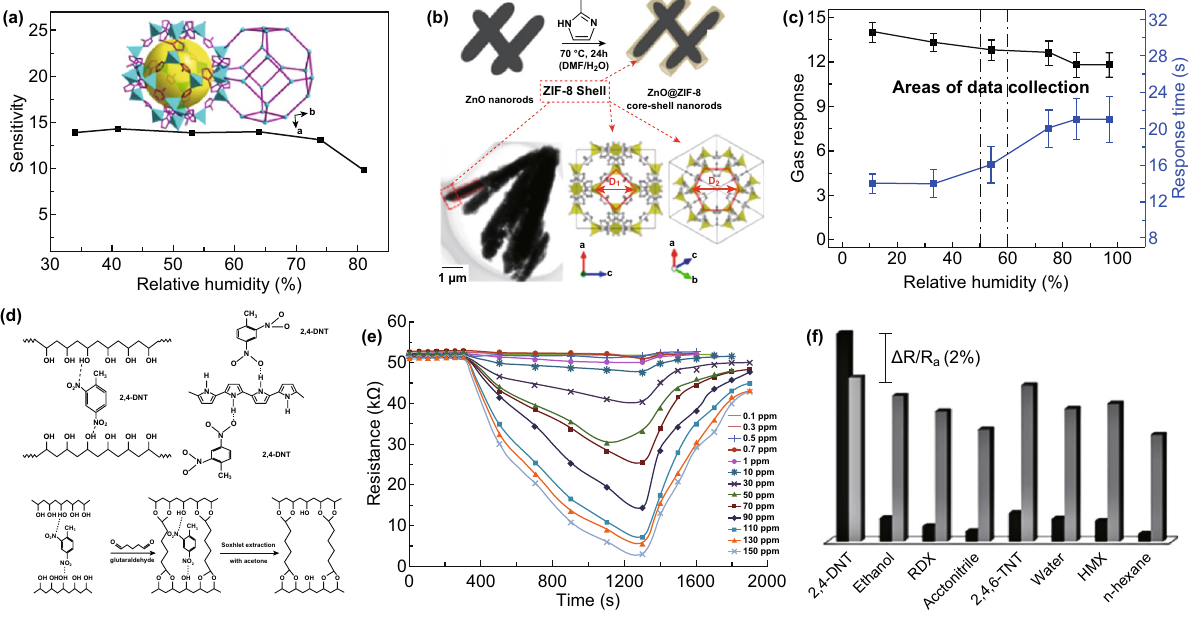
Fig. 17 a Effect of environmental humidity on sensitivity of ZIF-67 sensor (inset is the SOD-type structure of ZIF-67). Reproduce with per- mission [129]. Copyright 2014, American Chemical Society. b Schematic diagram of the ZnO@ZIF-8 NRs synthesized with ZnO NRs as a template; and c gas response and response time for 100 ppm formaldehyde as a function of the relative humidity. Reproduced with permission [131]. Copyright 2016, American Chemical Society. d Schema of the interaction of 2,4-DNT with the hybrid ingredients (PVA, PPy, and MIP). e Response of a fabricated chemi-resistor sensor coated with PVA/PPy/MIP hybrids with respect to the 2,4- DNT explosive vapor. f Column curves of PVA/PPy/MIP hybrids to different organic compounds. Reproduced with permission [132]. Copyright 2018, Wiley–VCH